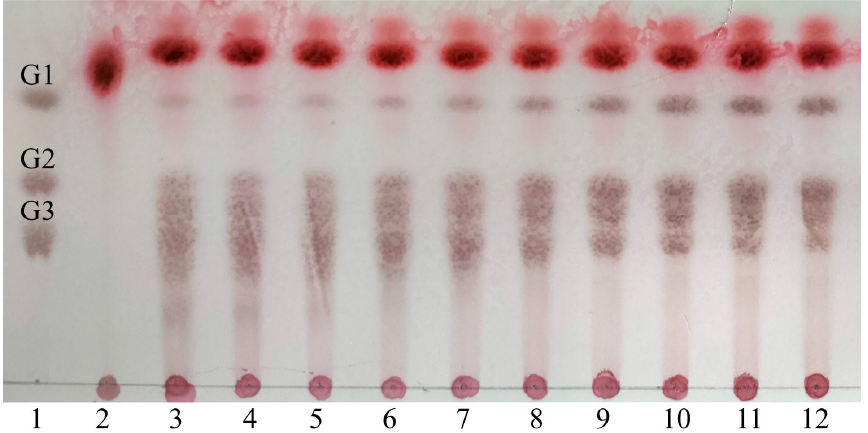
Figure 4. TLC analysis of the hydrolysis products of pePGA on commercial demethylated pectin. Lane 1, mixture of mono-galacturonic acid (G1), di-galacturonic acid (G2) and tri-galacturonic acid (G3); lane 2–12, the products at 0 min (lane 2), 2 min (lane 3), 5 min (lane 4), 10 min (lane 5), 20 min (lane 6), 30 min (lane 7), 1 h (lane 8), 2 h (lane 9), 3 h (lane 10), 4 h (lane 11) and 5 h (lane 12).